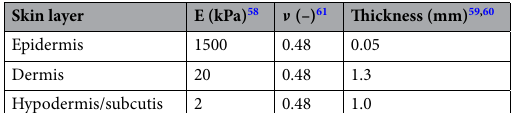
Table 2. Material and geometric parameters of the simulated skin